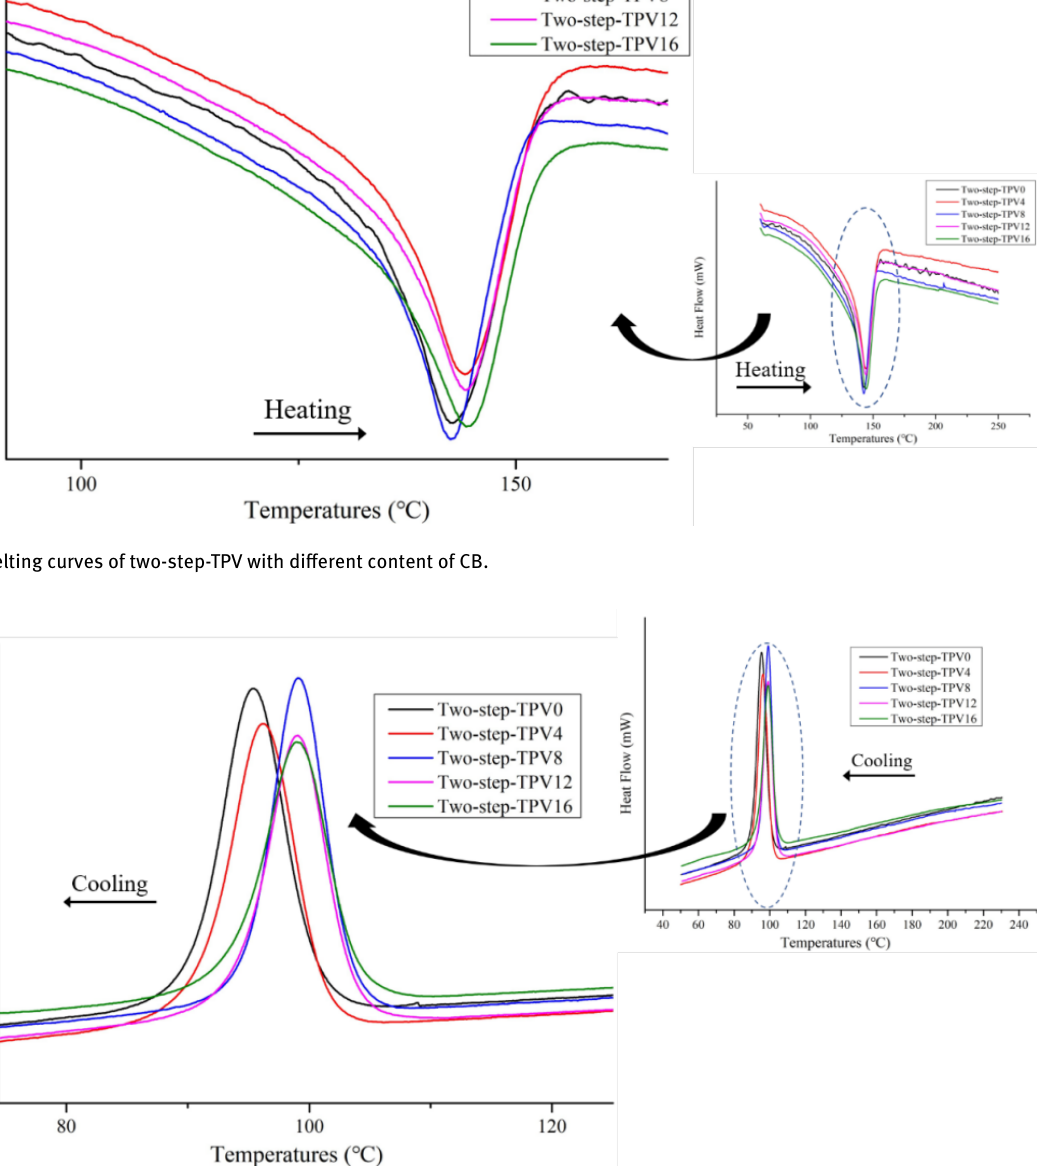
Figure 7: Cooling curves of two-step-TPV with different content of